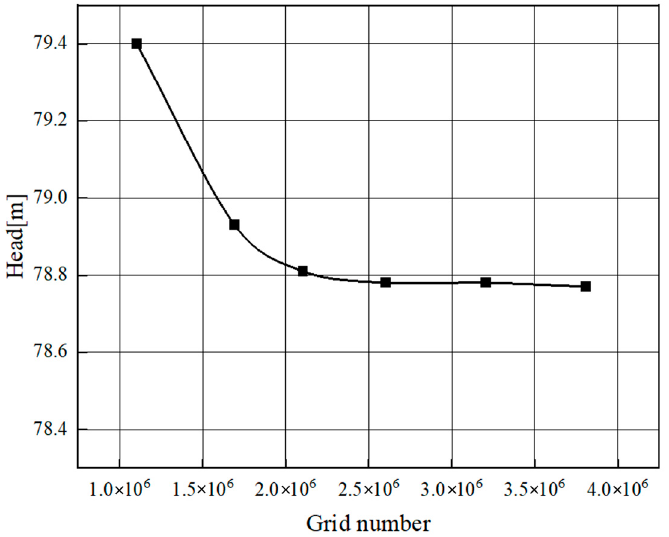
Figure 3. Grid independence analysis.